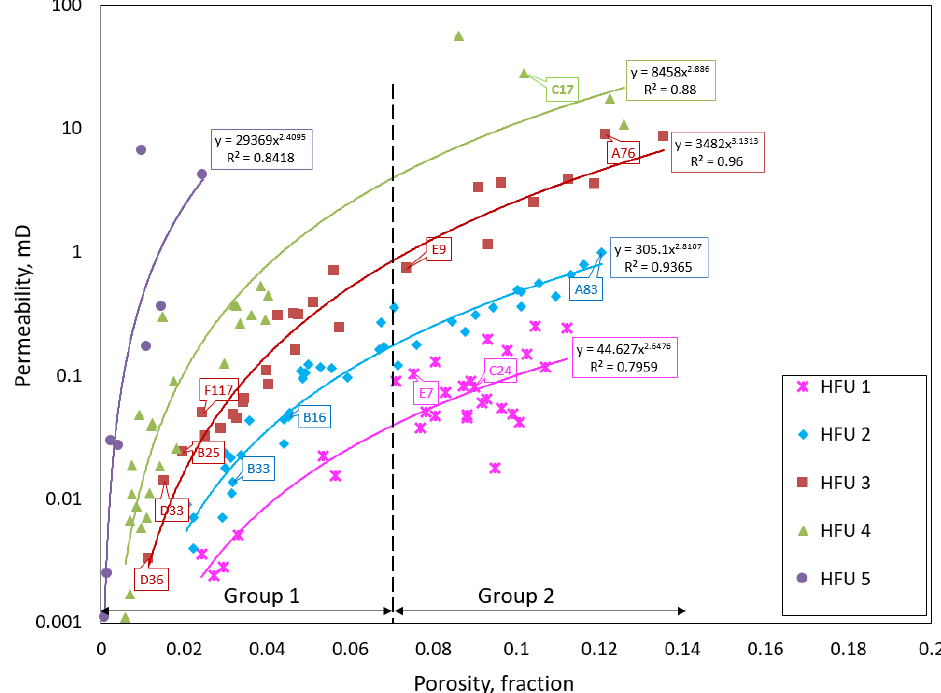
Figure 9. Cross-plot of helium porosity and helium permeability of 140 rock samples classified based on hydraulic flow units.